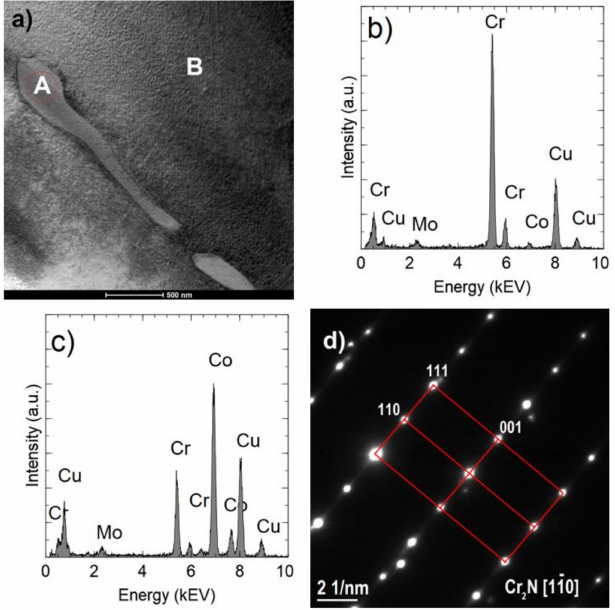
Figure 9. Cr 2 N longitudinal precipitates in the sample sintered in N 2 -5%H 2 at 1350 ◦ C ( a ). Scheme 96% at., Co 2% at., Mo 2% at.) ( b ). The result of chemical analysis in the area indicated by B (Cr 27% at., Co 70% at., Mo 3% at.) ( c ). SAED electron diffraction pattern for A area ( d